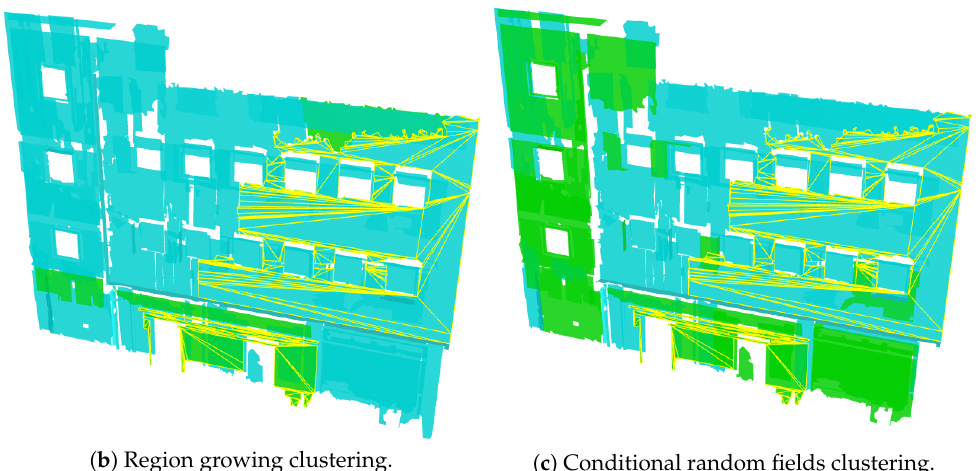
Figure 6. Comparison between the results of the proposed conditional random fields (CRF) clustering algorithm and a conventional region growing algorithm. The seed nodes are represented in yellow and the walls are colored according to their respective